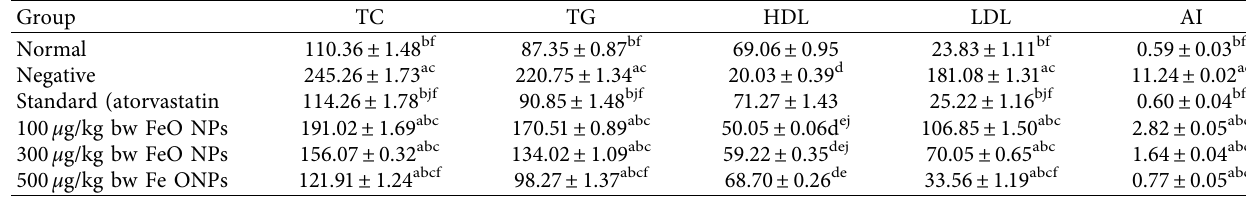
Table 2: Effect of iron oxide nanoparticles on lipid profile parameters in mg/dL.